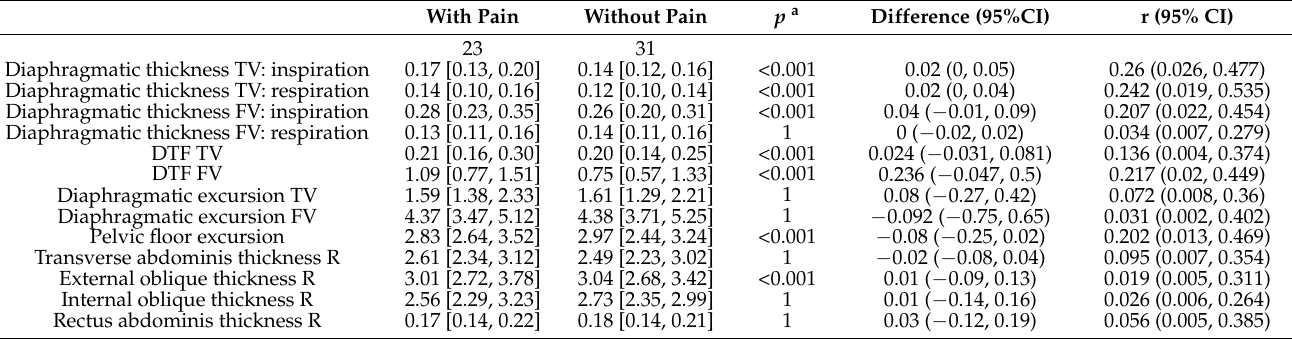
Table 2. Exact permutation test.